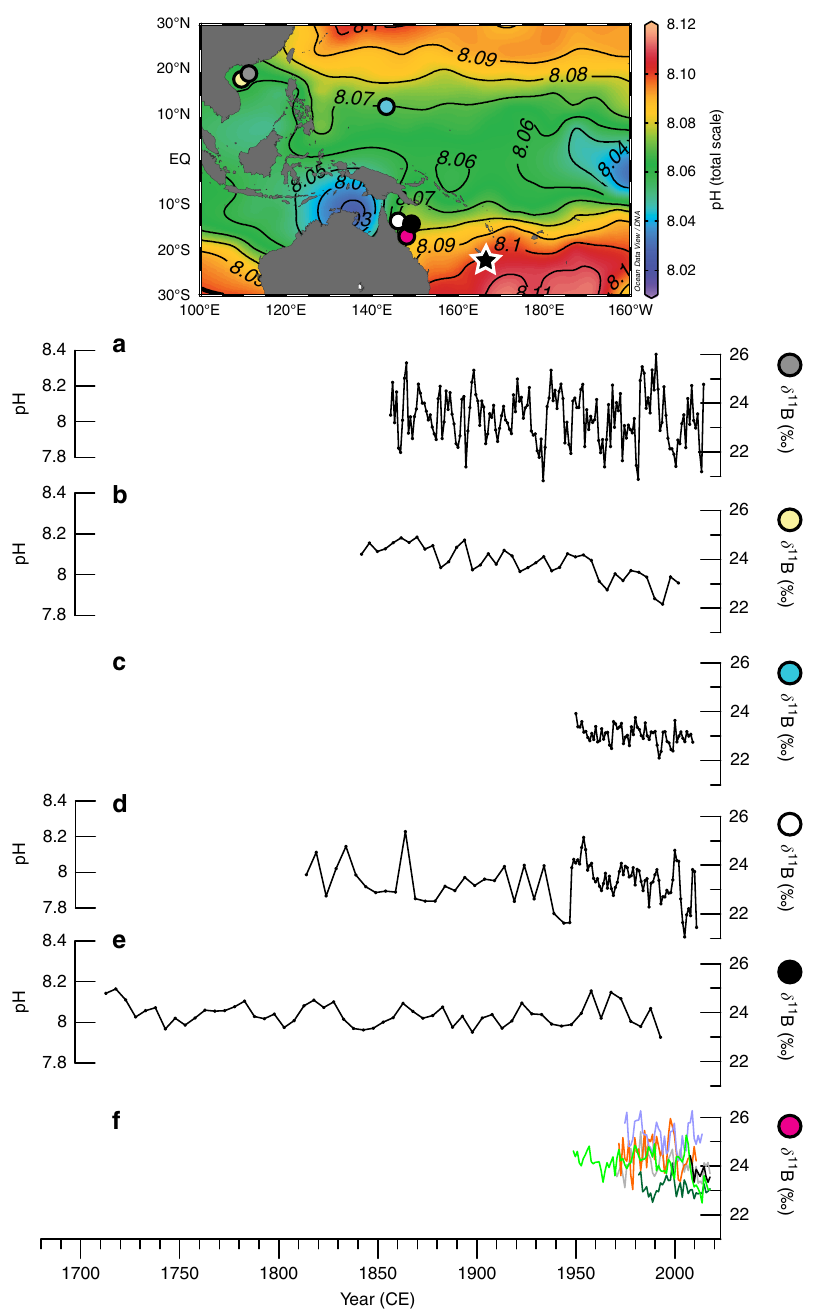
Fig. 4 Paci fi c Ocean modern coral δ 11 B and pH reconstructions. The published and publicly available coral δ 11 B and pH reconstructions from the Paci fi c Ocean are shown in the annual gridded mean estimated pH map 10 and listed on Supplementary Table 5. Each individual symbol corresponds to each respective record ’ s research location. The records are presented relative to the location of the cores from the north to the south. The locations include two records from a , b the South China Sea 13,14 , c one from Guam 17 , and d , e , f three sites in the Great Barrier Reef (GBR) 12,15,16 . The records from f Havannah Island, GBR 16 (magenta dot) are the results of six individual Porites coral colonies. All δ 11 B records are shown in their native temporal resolution as given in the original publication. The accompanying pH reconstructions are indicated on a secondary y axis if provided by the original publication and were not converted to seawater pH based on our methodology (see Methods). Map is produced using Ocean Data View ver. 4.7.4 (ref. 74 ) (http://odv.awi.de)